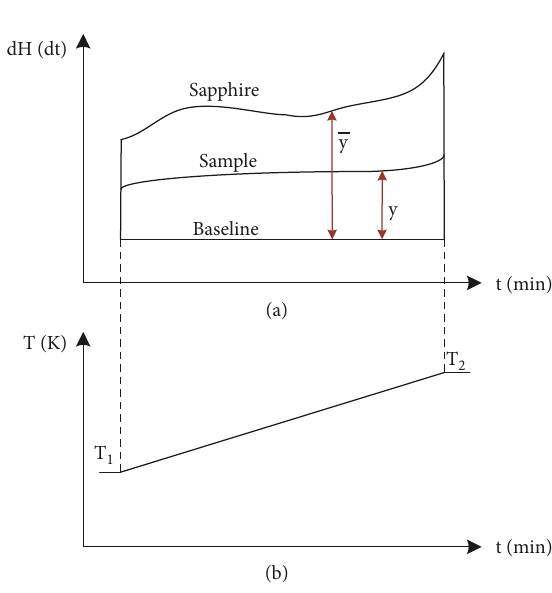
Figure 4: Calculation principle diagram of specific heat capacity based on the DSC curve.